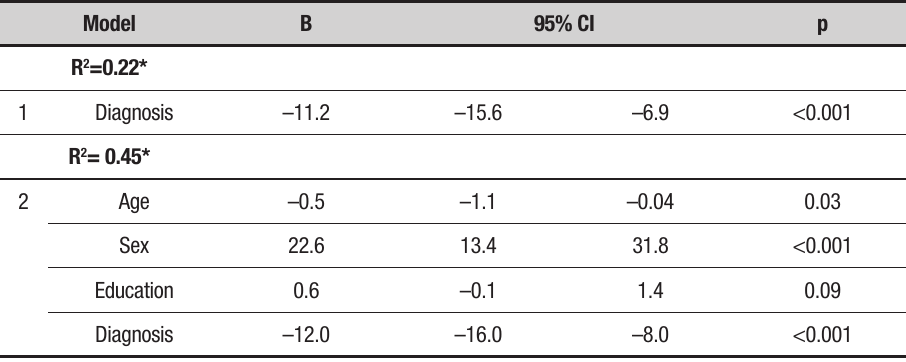
Table 2. Association between aerobic capacity and the different diagnoses.